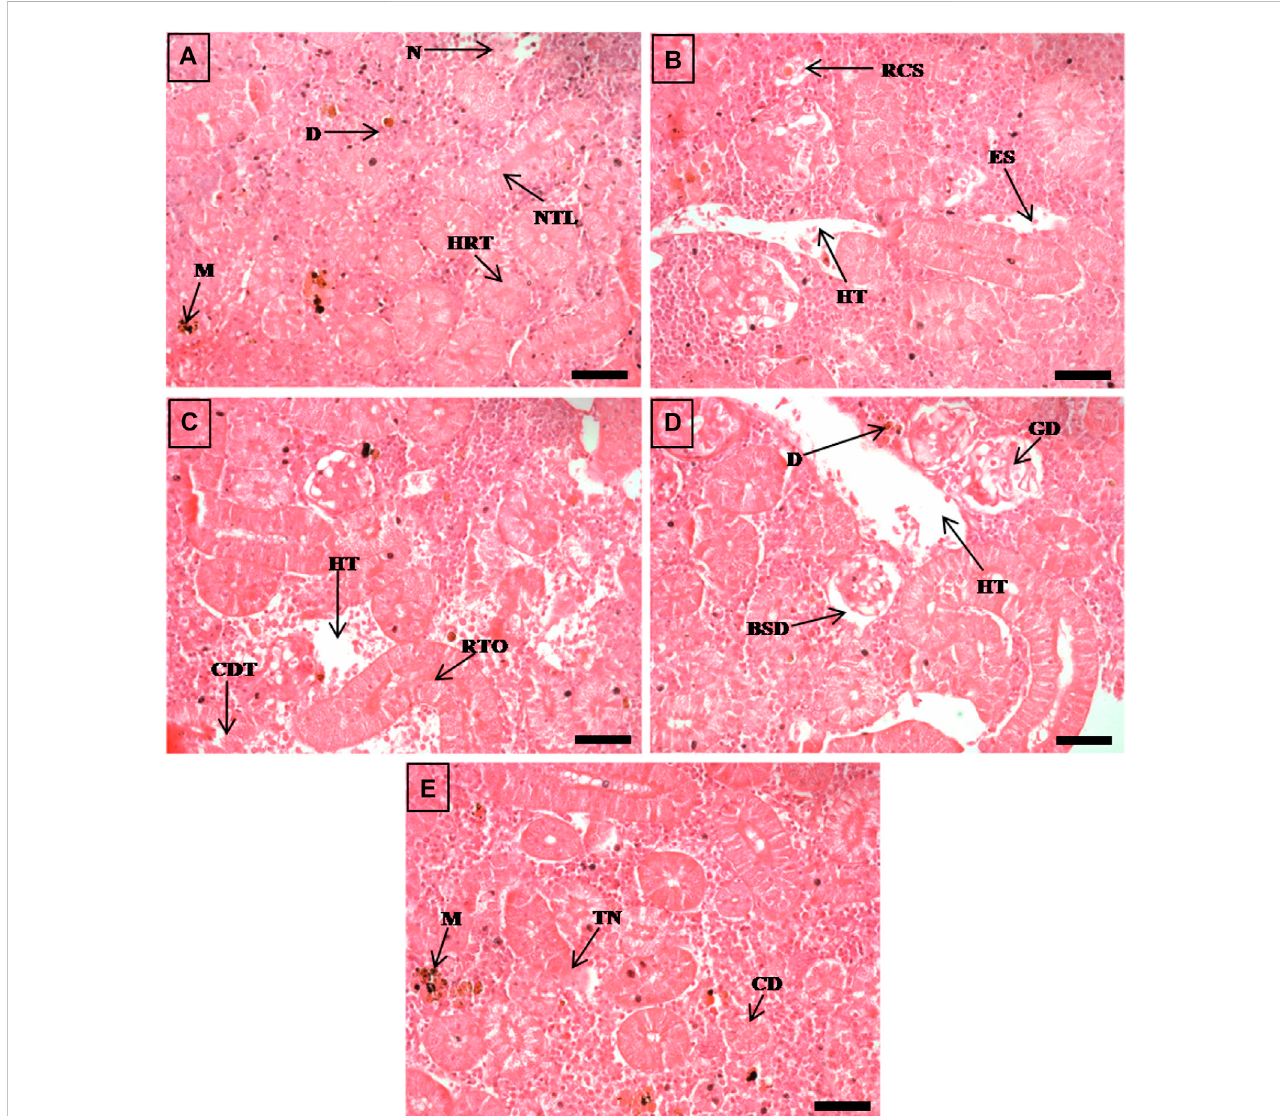
FIGURE 5 Thehistologicalsections(4 µm)ofkidneytissuesfromEB-administeredgoldenmahseeron21stday (A – E) ofEB-medication.Thehistologicalchangesin kidney tissues of fi shes fed with EB doses (A) at 50 μ g/kg fi sh/day showing melanomacrophages (M), necrosis (N), narrowing of tubular lumen (NTL), hypertrophy in renal tubule (HRT), droplet like aggregation (D) ; (B) at 100 μ g/kg fi sh/day showing renal corpuscle shrinkage (RCS), enlarged sinusoids (ES), decreased hematopoietic tissue (HT); (C) at 250 μ g/kg fi sh/day showing cellular degeneration in renal tubule (CDT), renal tubule occlusion (RTO), decreased hematopoietic tissue (HT); (D, E) at 500 μ g/kg fi sh/day showing Bowman ’ s space dilation (BSD), glomerular degeneration (GD), decreased hematopoietictissue(HT),dropletlikeaggregation (D) ,melanomacrophages(M),tubularnecrosis(TN),cloudydegenerationoftubules(CD).TheH&Estained sections are visualized at magni fi cation of ×400 under inverted light microscope (Olympus IX53, Canada). The scale bar value depicted in the right bottom corner (A – E) is 20